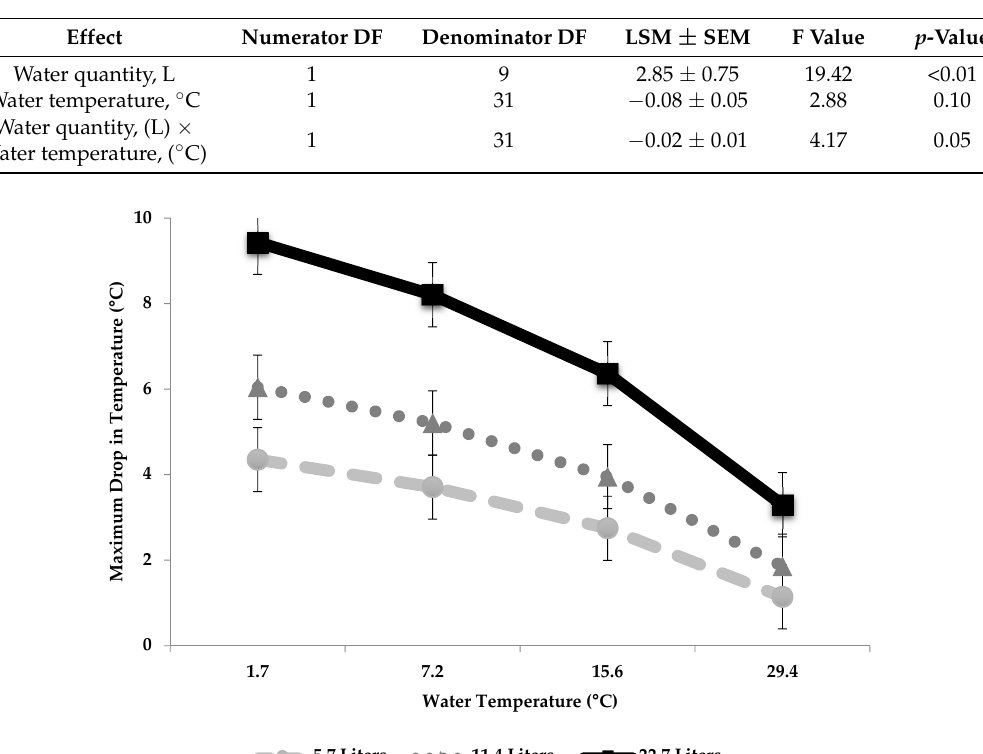
Figure 1. The effect of water quantity (5.7 L, 11.4 L, 22.7 L), water temperature (1.7 ◦ C, 7.2 ◦ C, 15.6 ◦ C and 29.4 ◦ C) and their interaction on the maximum degrees ( ◦ C) dropped in reticuloruminal temperature for feed restricted, once daily drenched pregnant cows ( n = 12) explained with the equation: Temperature Decrease = 1.56 + (1.45 × Water Quantity (L)) − (0.003 × Water Temperature ( ◦ C)) − (0.04 × (Water Quantity (L) × Water Temperature ( ◦